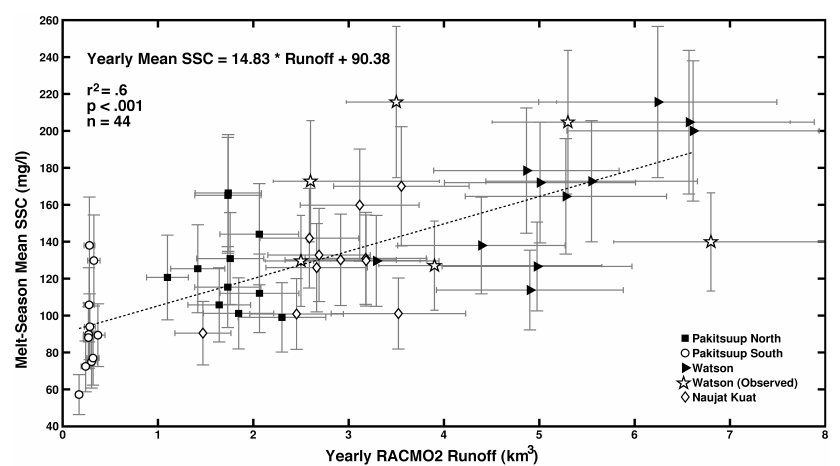
Figure 11. Relationship between yearly RACMO2 modeled runoff and melt-season mean suspended sediment concentration (SSC msm ) for four river plumes. Watson River observed discharge (Hasholt et al., 2013) and SSC msm plotted for comparison, but these data were not included in yearly mean SSC–runoff relationship. Table 3. Melt-season mean suspended sediment concentration (SSC msm ) percent of 13 year mean. Underlined values are statistically below the mean, bold values statistically above. Pakitsuup fjord Kangerlussuaq fjord Ameralik fjord Year North South Watson Umiiviit Sarfartoq Naujat